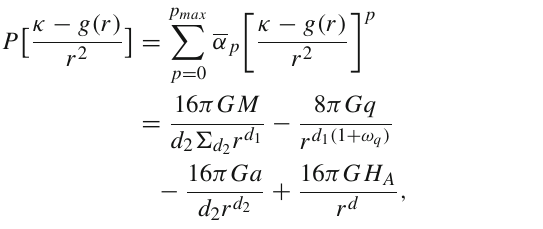
Fig. 11 The plot of Gibb’s energy G (Eq. (3.17)) vs r + for fixed values of l = 0 . 9, H 1 = 100, δ d , 2 n − 1 = 10, ω = − 0 . 5, (cid:13) = 1, d = q d − 2